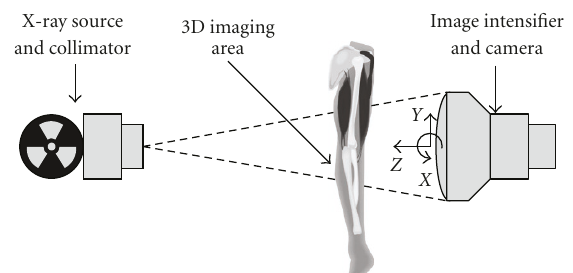
Figure 1: Configuration of a single-plane fluoroscopic acquisition